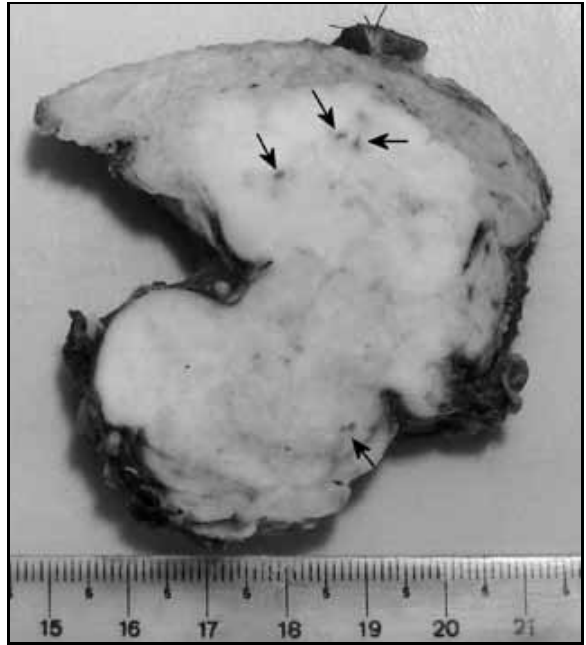
Figure 2 – Gross appearance: the cut surface of the parotid mass tumor is grayish-white and brilliant, with frequent areas of hemorrhage and necrosis